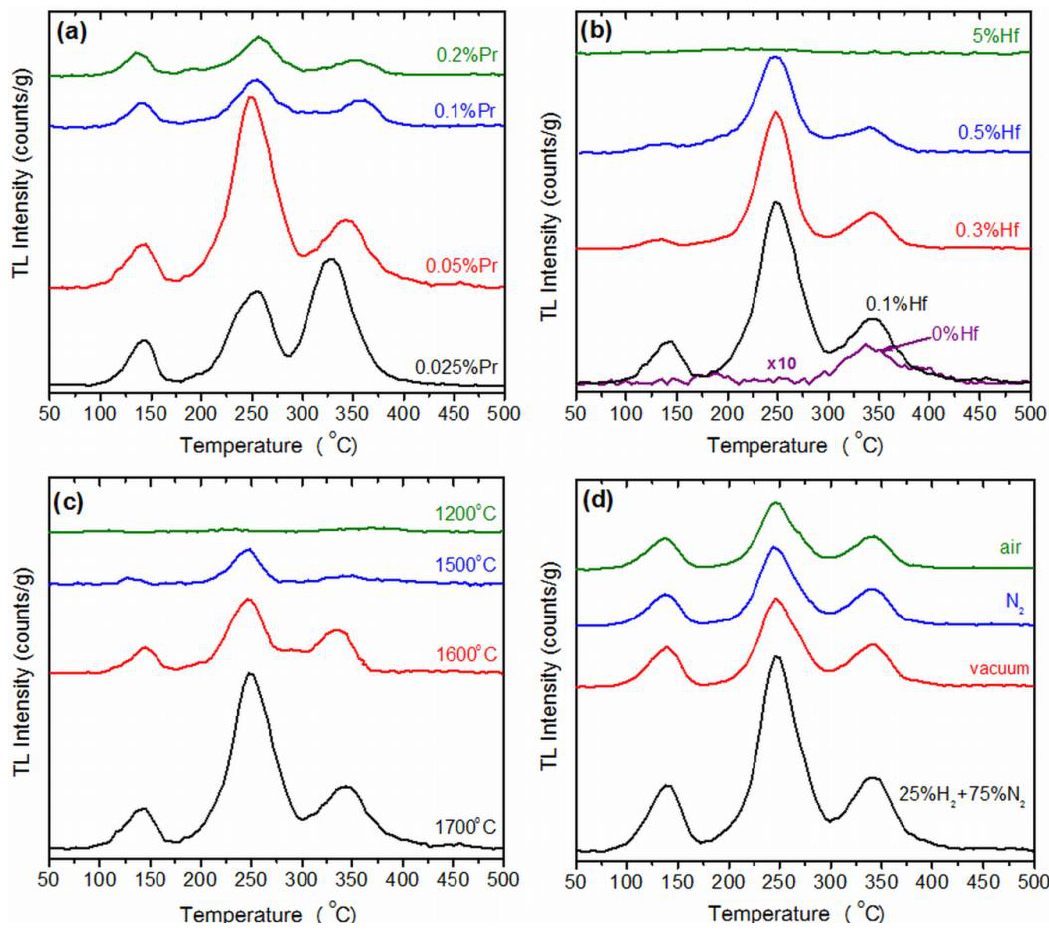
O : x %Pr,0.1%Hf ( x = 0.025%, 0.05%, 0.1%, 0.2%) 2 3 + 75%N ; ( b ) TL glow curves 2 2